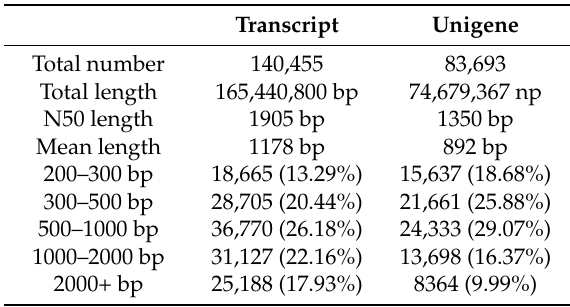
Table 1. Summary for the graft union transcriptome.